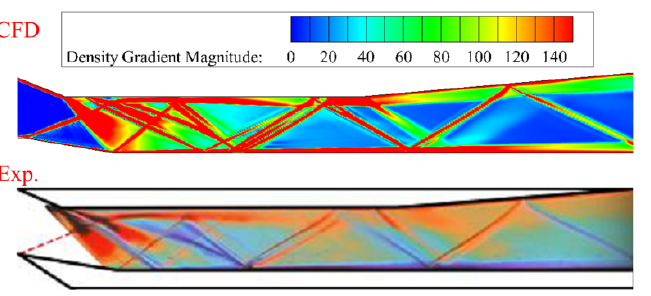
Figure 5. Schlierens of the flow fields obtained by the current numerical method and experimental result.